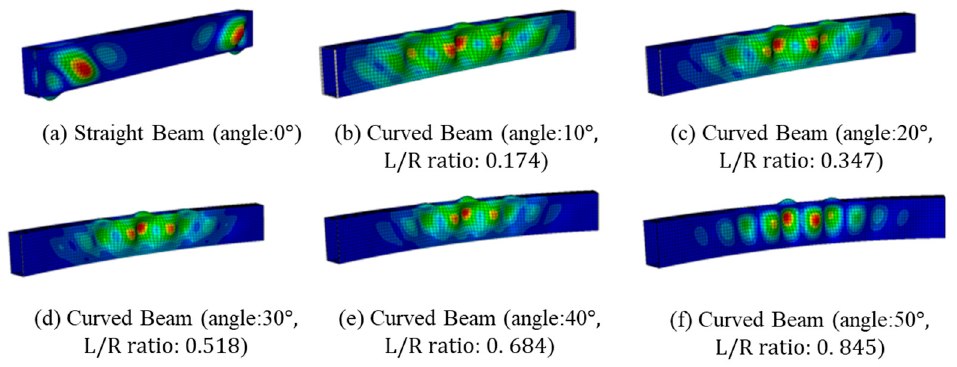
Figure 29. Buckling shape of some selected